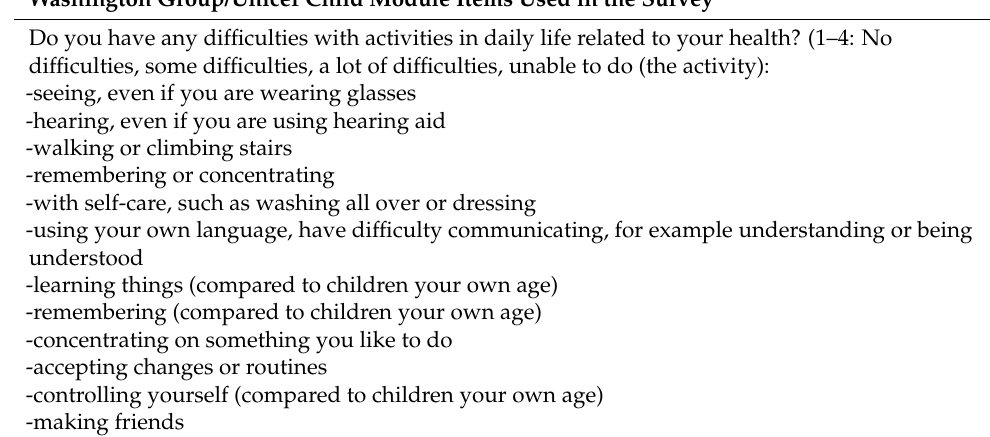
Table 3. Washington Group/UNICEF Child Module